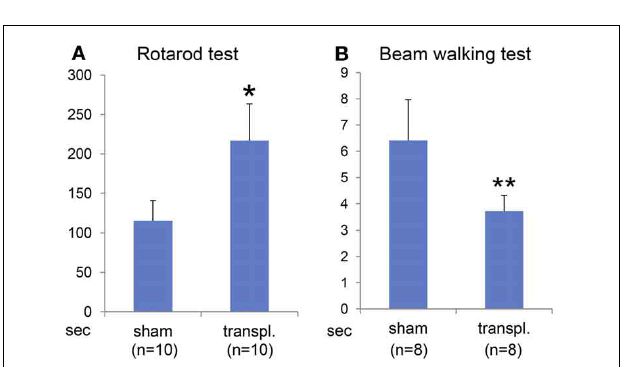
cells injection site. GFP-positive axons from the graft entered and extended within the corpus callosum (CC) just below the injection site (B) , lateral side (D) , striatum (E) , internal capsule (IC) ( G , thin arrows), and also contralateral CC ( C ). ( I, I’ ) Axon in the CA1 area in the hippocampus (thick arrows). Scale bar; ( B–E, G ) 100um, ( I, I’ ) 50um.